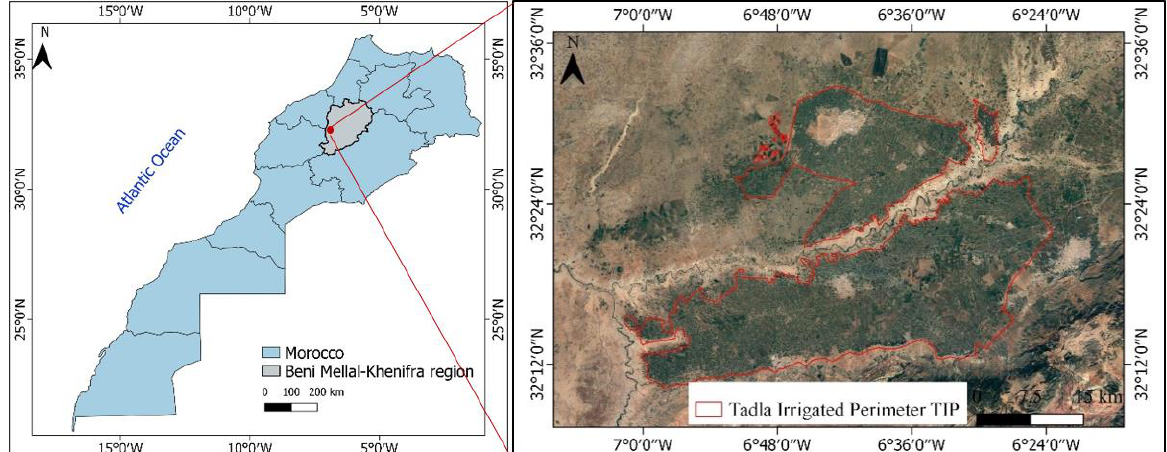
Figure 1. Location of the study area at the national scale ( left ). Scene of Tadla Irrigated Perimeter ( right ). ( right